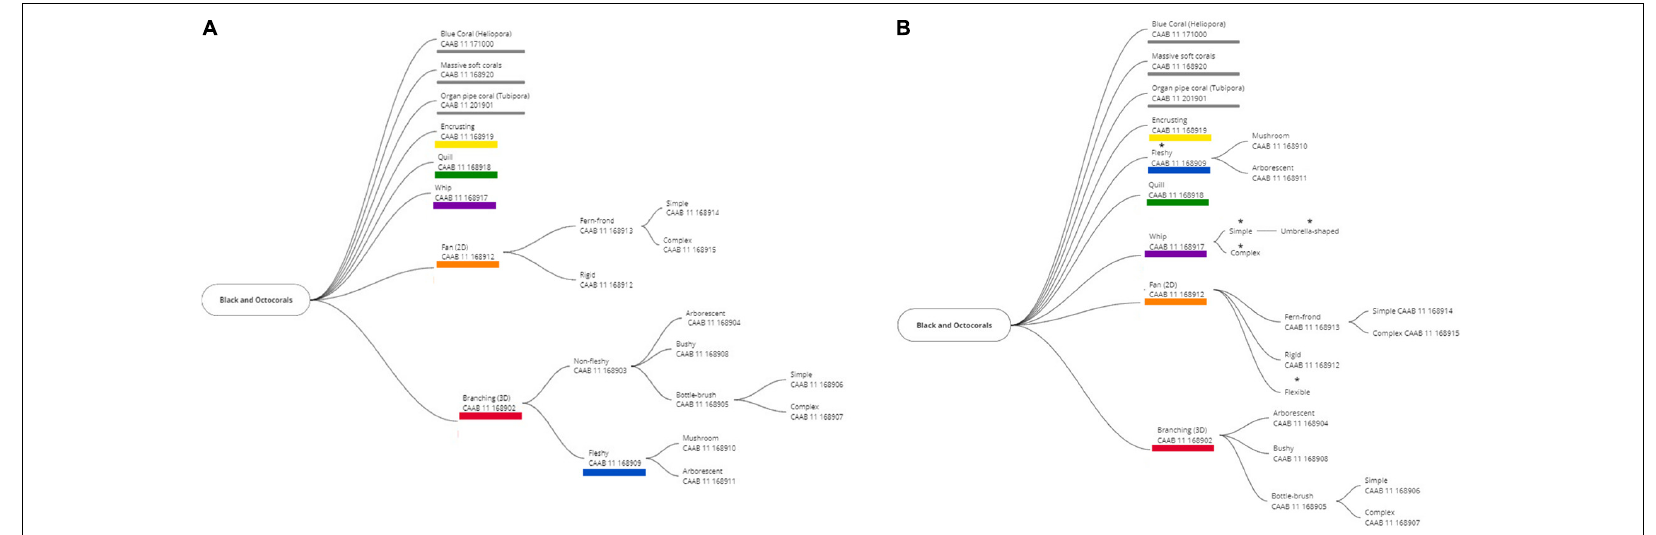
FIGURE 2 | The original (A) and revised (B) CATAMI classification system for black and octocorals. *Indicates added groups and changed relationships. Primary branches, which are not colored have not been used in this